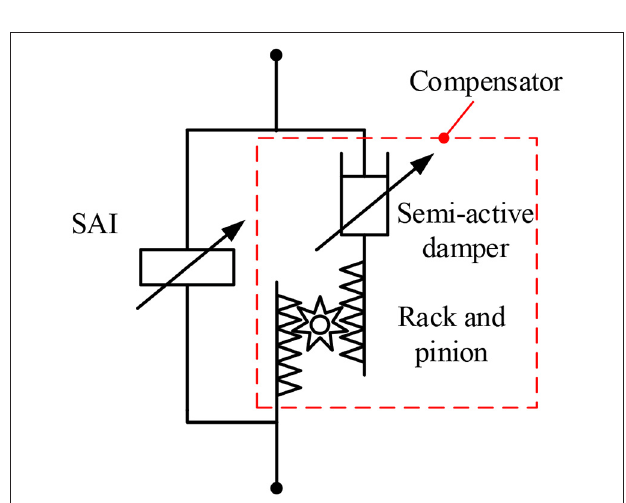
FIGURE 10 | Schematic of the SAI with a compensator.